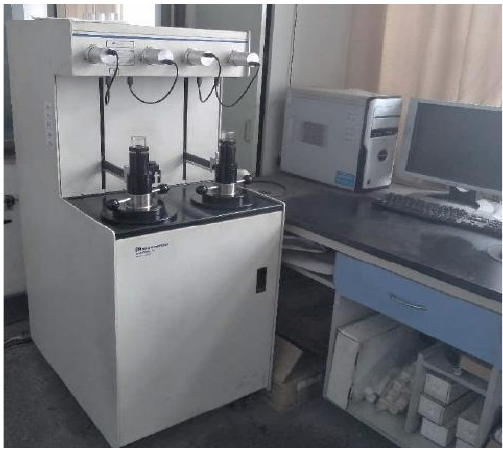
Figure 15. MIP test operation.